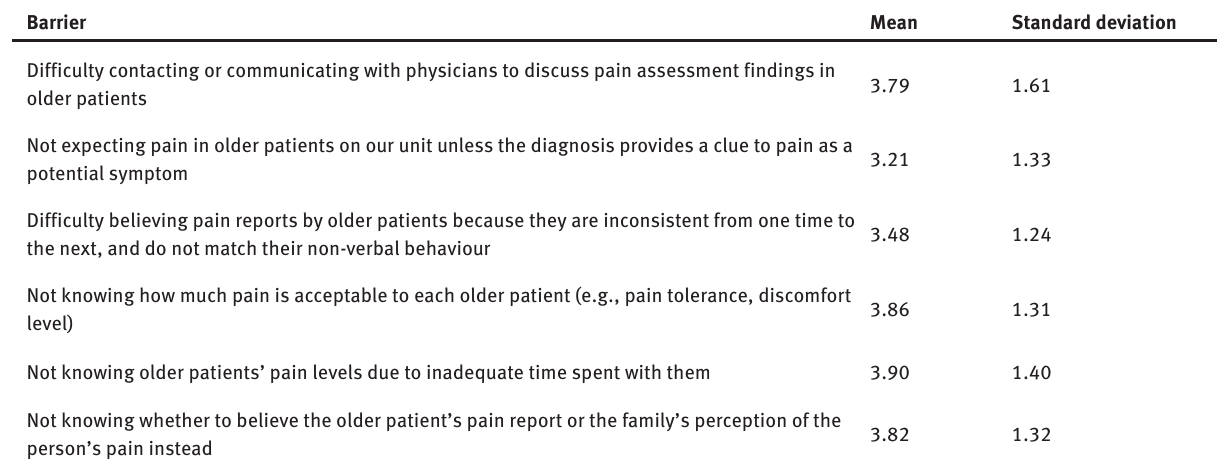
Table 4: Frequency characteristics of obstacles to optimal pain assessment and treatment in elderly patients associated with nursing staff.